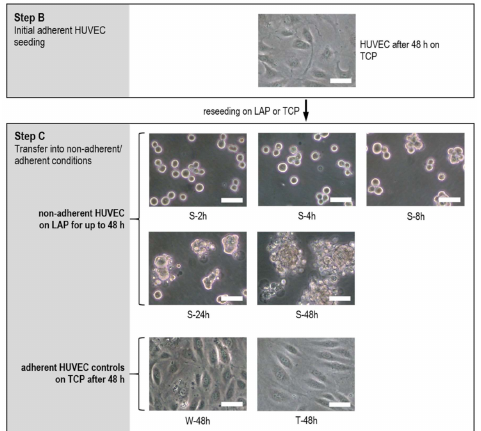
Figure 2. Increasing aggregation and progressing loss of cell integrity of HUVEC under nonadherent conditions on LAP for up to 48 h (S-2h till S-48h) compared to adherent grown controls W-48h and T-48h on TCP. Pictures taken by light microscopy in phase contrast mode at 20-fold primary magnification (scale bar: 50 µ m).